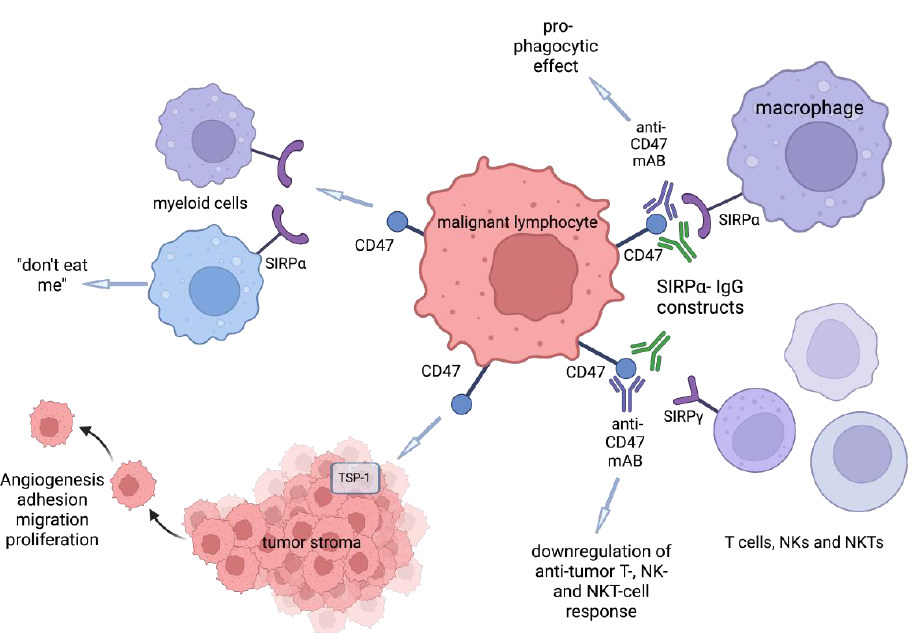
Figure 1. Anti-CD47 mAb boosts tumor phagocytosis by macrophages but dampens the anti-tumor T- cell response due to nonspecific blockage of SIRPα and SIRPγ.